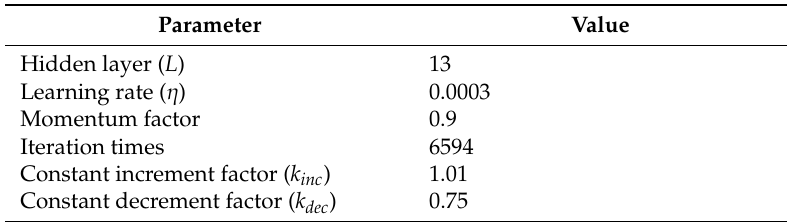
Table 2. Parameters of the neural network with the even training.